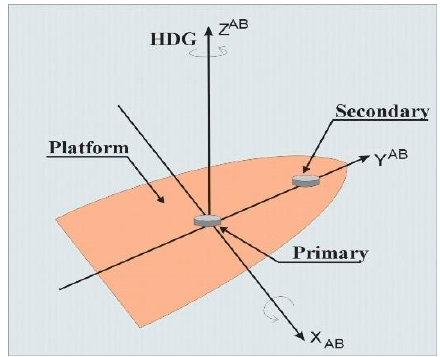
Figure 1. The idea of the use of two antennas to determine the heading of the ship [1].